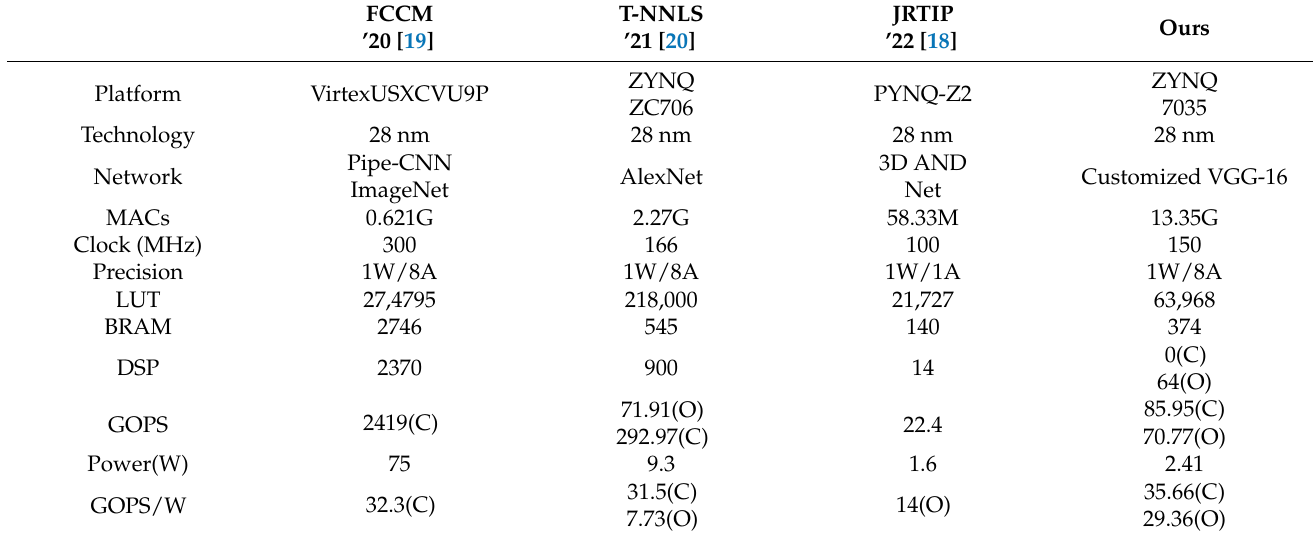
Table 7. Comparison with other implementations for binary neural